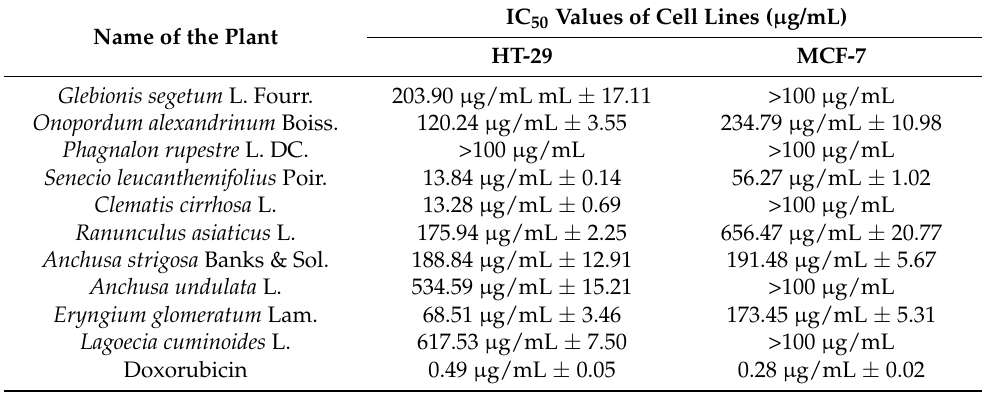
Table 4. Cytotoxic activity (IC 50 ) of plant extracts under investigation towards HT-29 and MCF-7 cell lines. Name of the